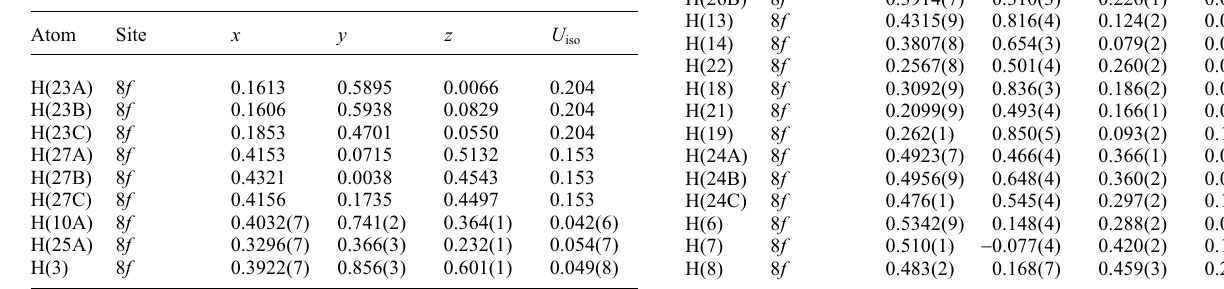
Table 2. Atomic coordinates and displacement parameters (in Å 2 ) .